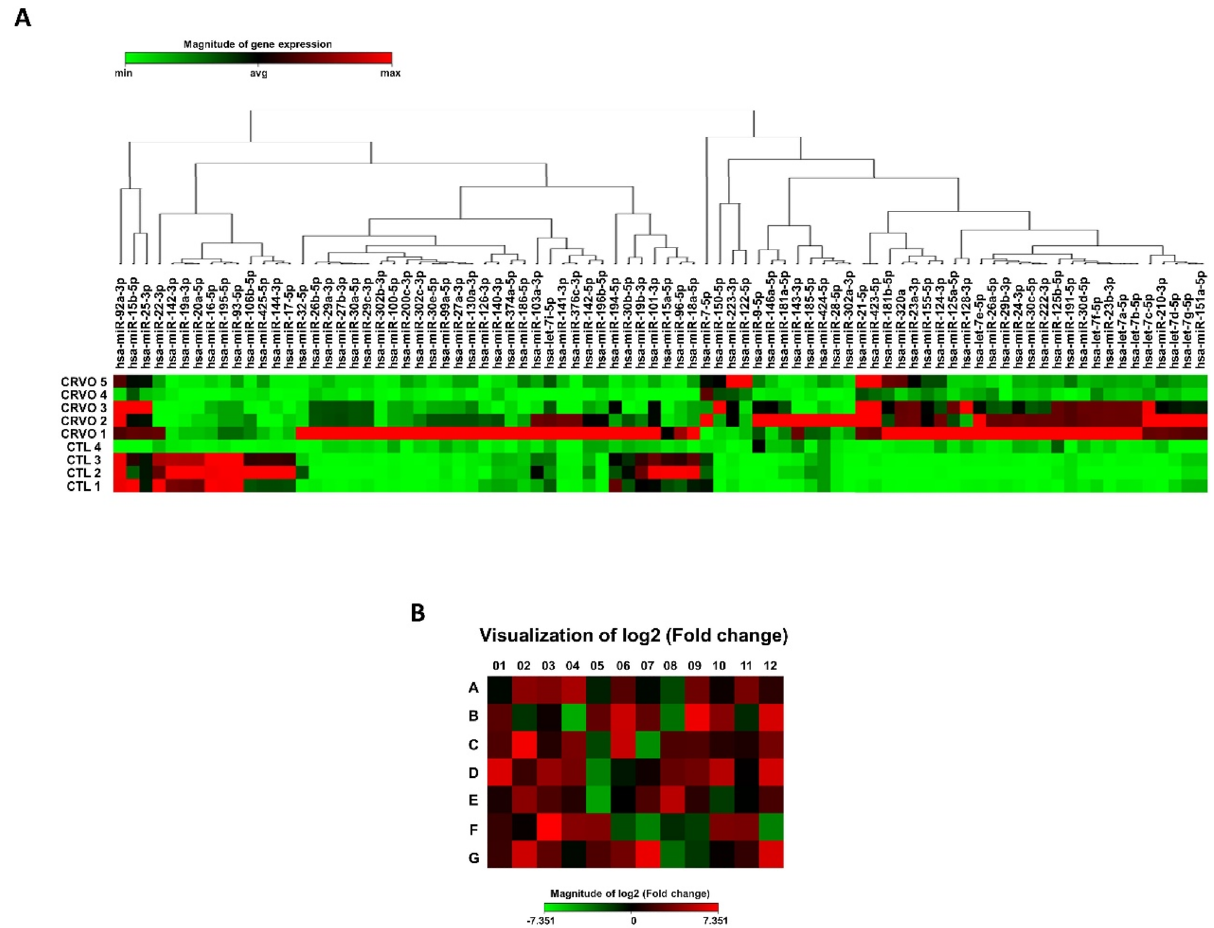
Figure 1. Clustergram and heatmap images representing miScript miRNA PCR array results using aqueous humor samples of patients with CRVO and control subjects. ( A ) Clustergram shows co-regulated genes across each sample. ( B ) Heatmap displays fold regulation expression data of 84 genes between the CRVO and control groups. The color reflects the magnitude of gene